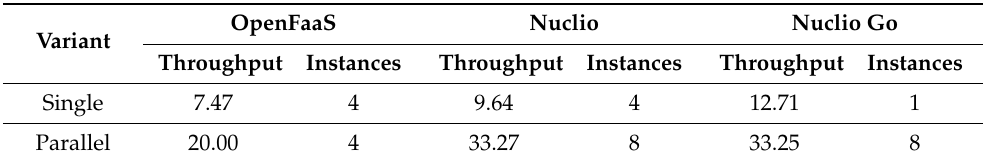
Table 2. Peak average input processing rates in MiB/s for byte reversal workload, single and parallel